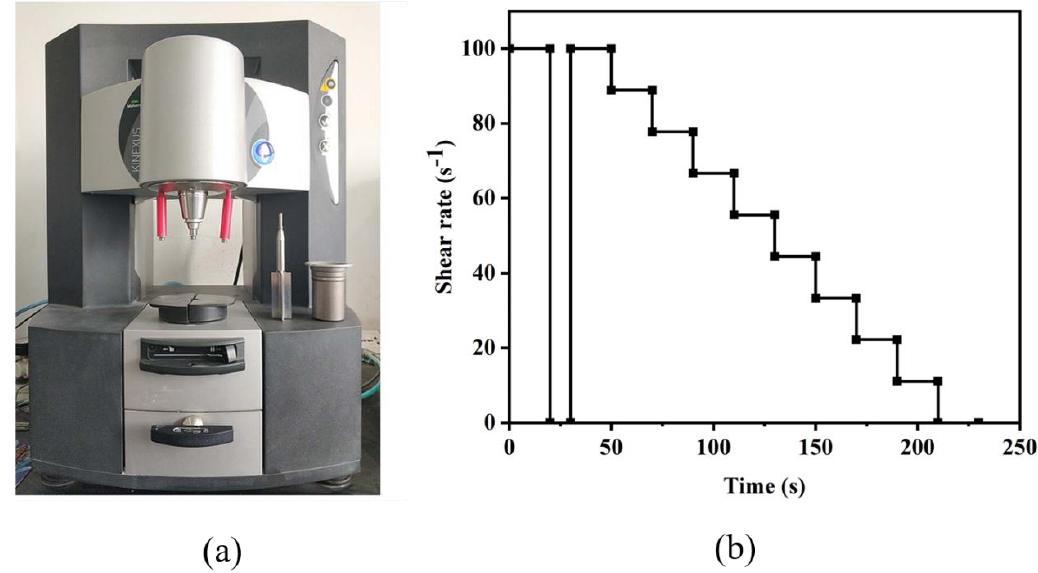
Figure 4. Malvern rheometer ( a ) and rheological test protocol ( b